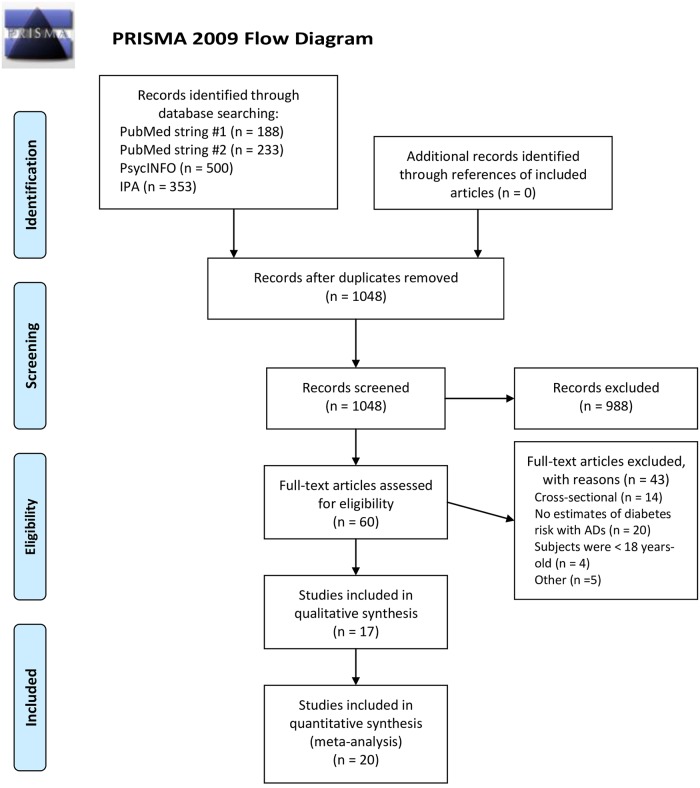
PRISMA Flow-Diagram of the systematic review.Form: Moher D, Liberati A, Tetzlaff J, Altman DG, The PRISMA Group (2009). Preferred Reporting items for Systematic Reviews and Meta-Analyses: The PRISMA Statement. PLoS Med 6(7): e1000097. doi:10.1371/journal.pmed1000097. For more information, visit
www.prisma-statement.org.